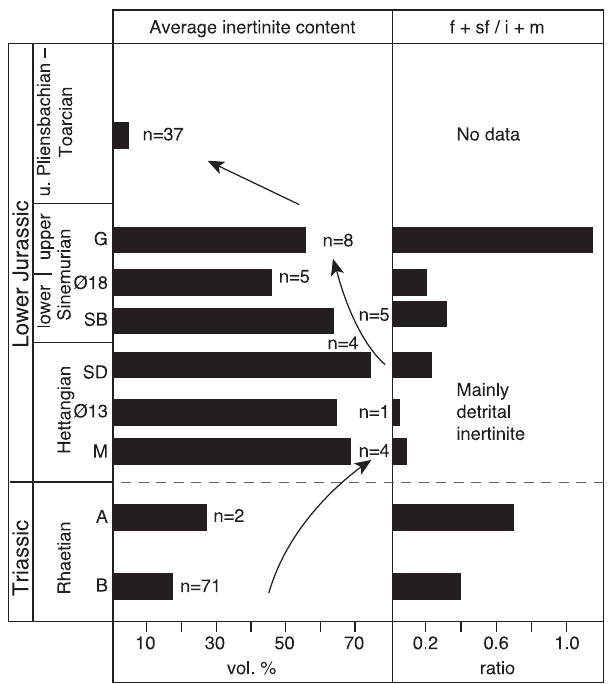
Figure 2. The average inertinite content of coal and coaly beds straddling the Triassic–Jurassic boundary . A significant increase in inertinite is recorded across the boundary with a maximum content in the Hettangian. Most of the inertinite in the Rhaetian A-bed and the Hettangian and lower Sinemurian beds is detrital (inertodetrinite). B: B- bed, Scania; A: A-bed, Scania; M: Munkerup, Bornholm; Ø13: Øresund- 13 well; SD: Sose Bugt bed D, Bornholm; SB: Sose Bugt bed B, Bornholm; Ø18: Øresund-18 well; G: Galgeløkke,